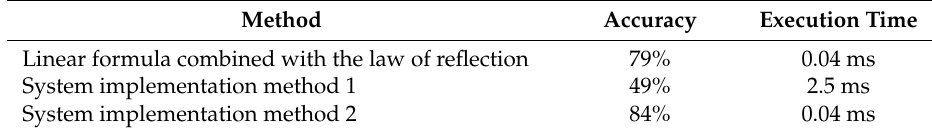
Table 7. Accuracy and execution time of the hockey end position prediction of di ff erent